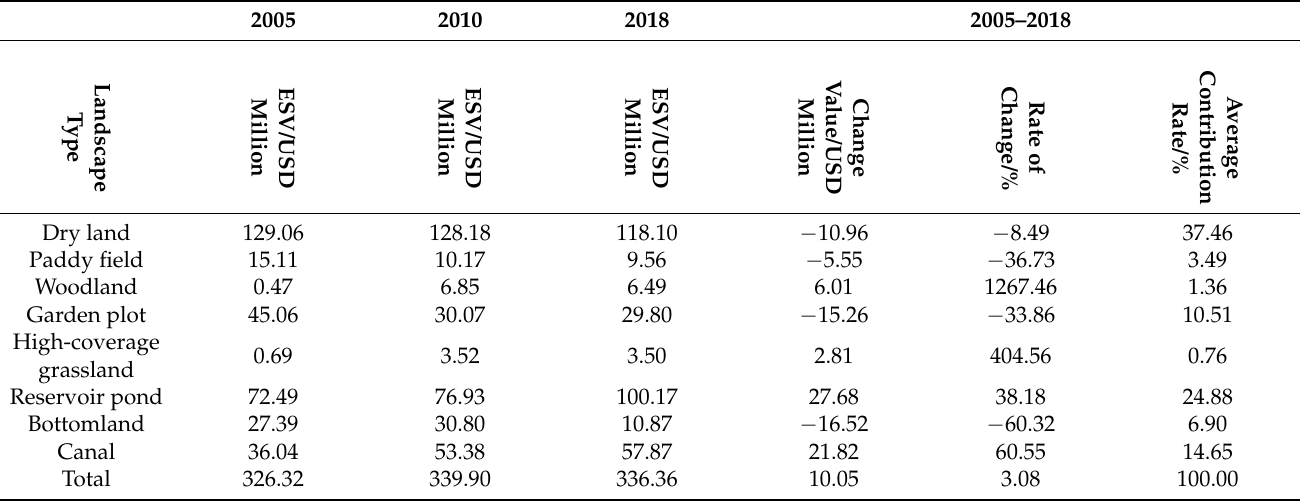
Table 4. Changes in ESV of different landscape types in Zhongmu County from 2005 to 2018.